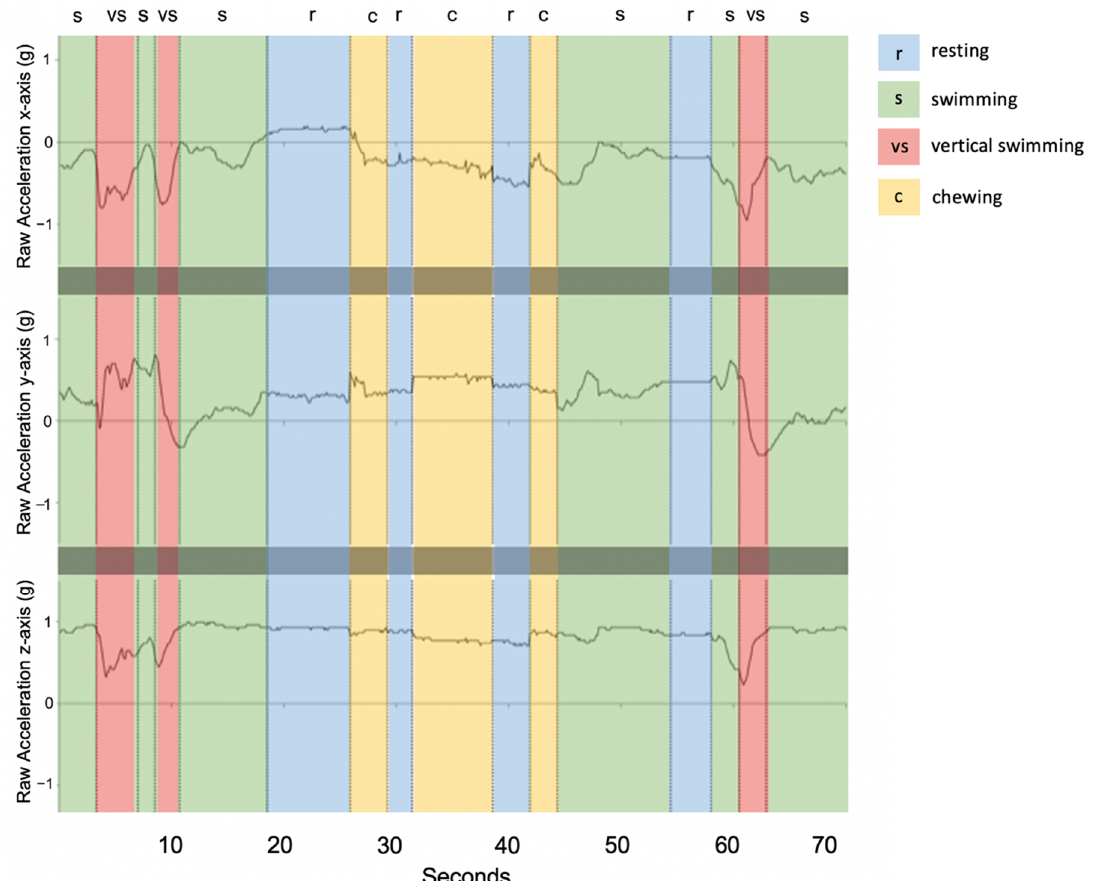
Figure 3. Example of raw acceleration data over a 70-s time window (shark ID 5541) engaging in each of the four behaviour classes. Vertical dashed lines indicate transitions between behavioural states where r: resting (blue), s: swimming (green), vs: vertical swimming (red), and c: chewing (yellow).